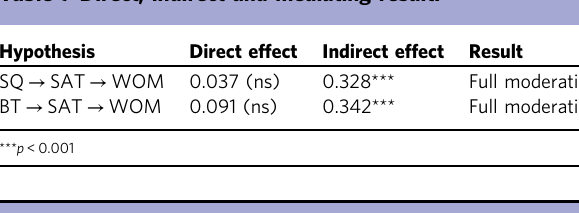
Table 7 Direct, indirect and mediating result.